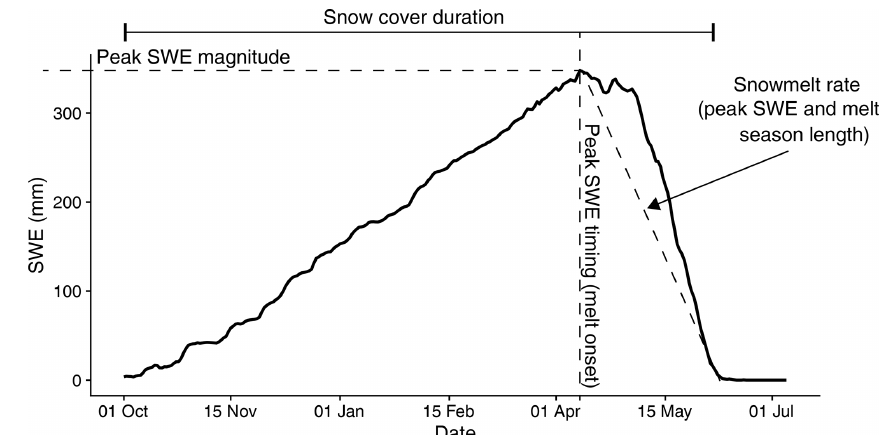
Figure 2. Example plot showing seasonal snow cover evolution, adapted from Trujillo and Molotch